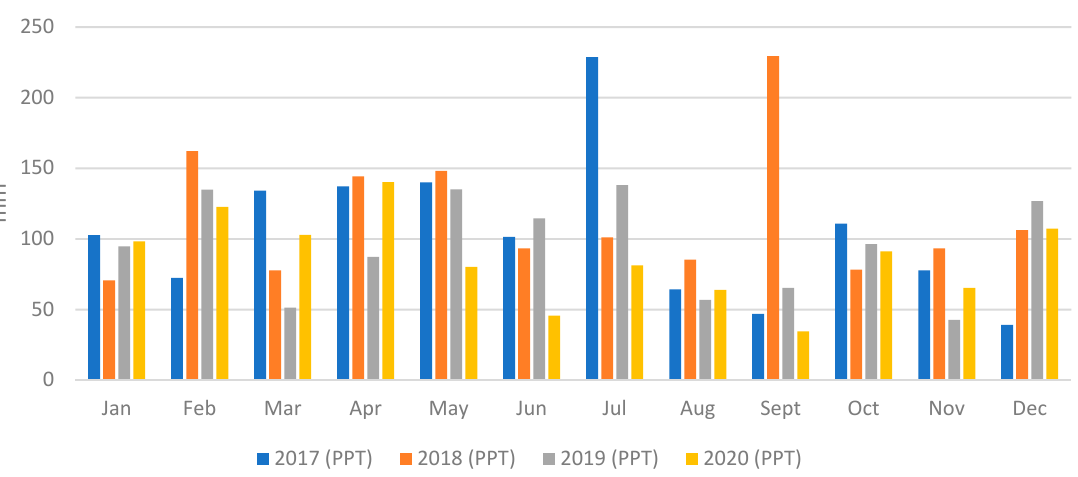
Figure 3. Monthly average precipitation from 2017 to 2020 for Morgantown, West Virginia, USA, which is 22.5 km from the Ruby Run study site (NOAA 2022).